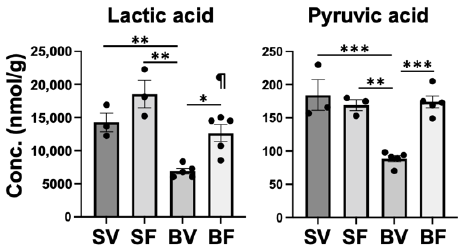
Figure 9. Effects of burn injury and FTI-277 on lactic acid and pyruvic acid. SV: Sham-Vehicle; SF: Sham-FTI; BV: Burn-Vehicle; BF: Burn-FTI, * p < 0.05, ** p < 0.01, *** p < 0.001, ¶ p < 0.05 vs. Sham + FTI.